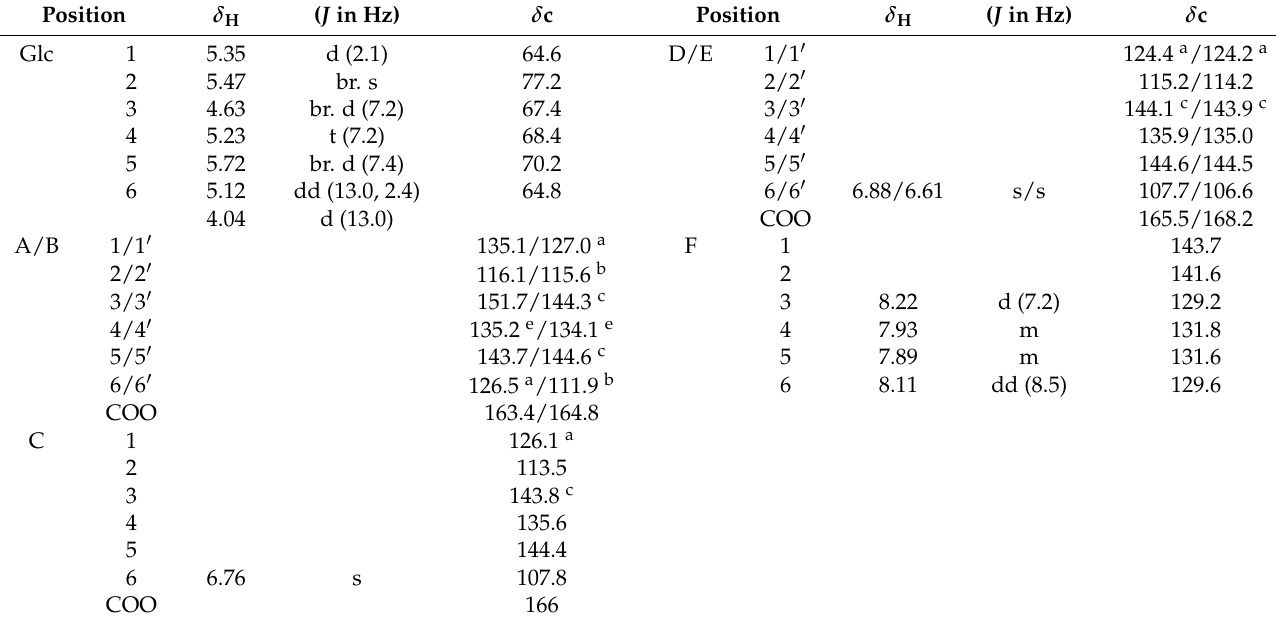
Table 1. 1 H (500 MHz) and 13 C (126 MHz) NMR data of 6 (in acetone- d 6 ).